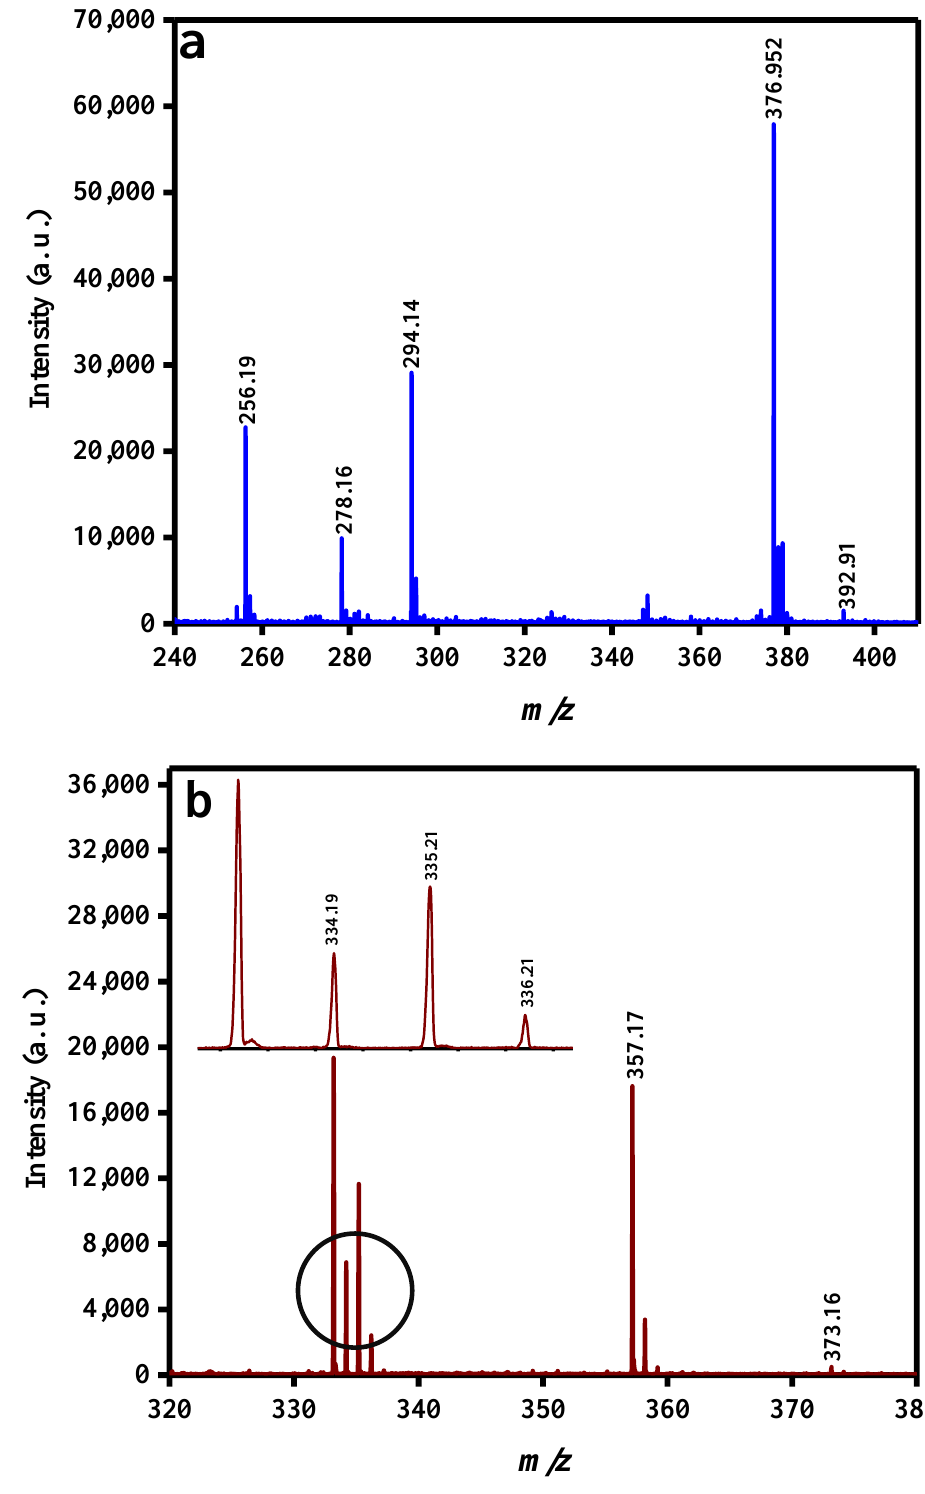
Figure 5. SALDI-MS spectra of ( a ) dimethametryn, napropamide, thiodicarb, and ( b ) strychnine using FeNi MANPs as a substrate.